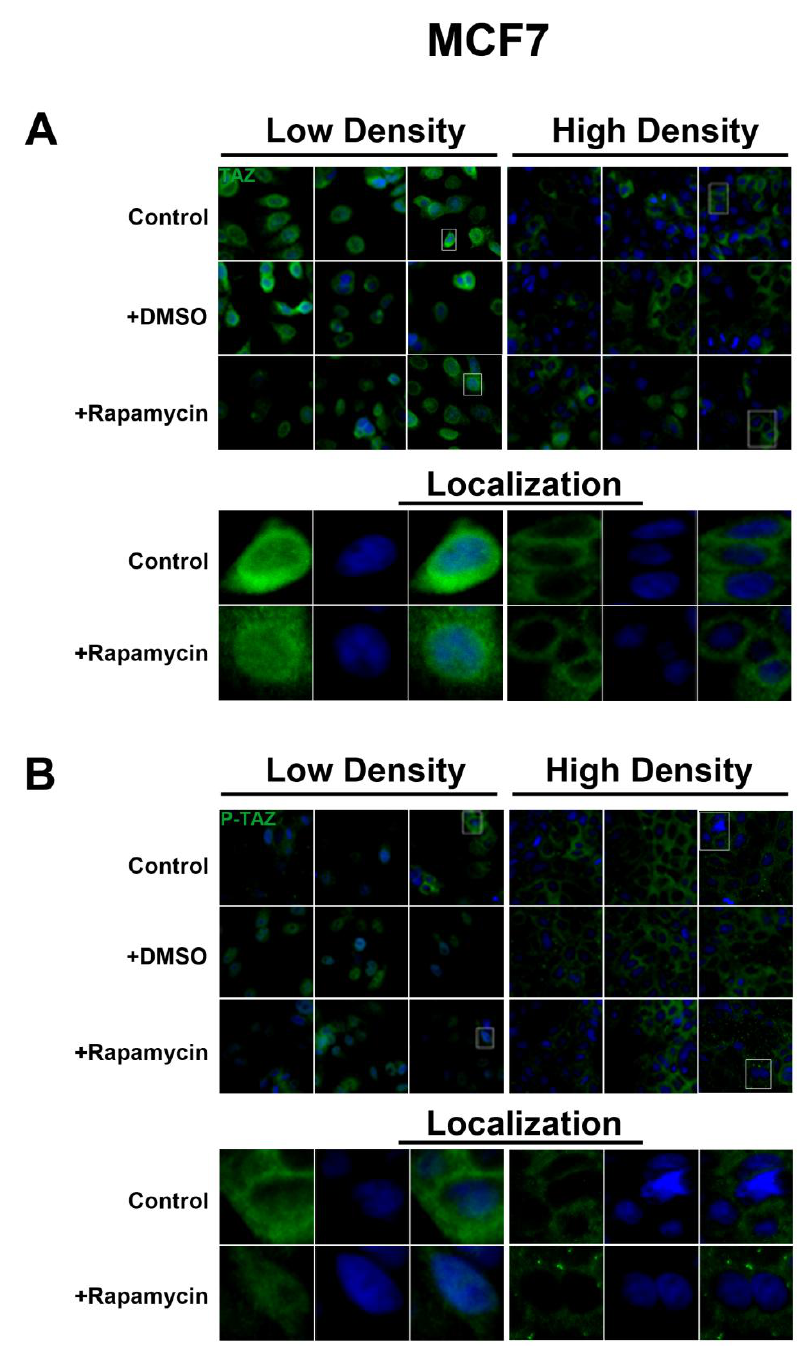
Figure S3. mTOR pathway inhibition does not affect TAZ/P-TAZ expression or localization in MCF7 cells. (A-B) Immunofluorescent staining of TAZ (A, green) and P-TAZ (B, green) in MCF7 cells with and without rapamycin treatment at low and high cell density conditions demonstrates no changes. Bottom panels represent box in top images: localization of TAZ and P-TAZ at low cell density conditions demonstrates mostly nuclear localization that does not change upon rapamycin treatment, while in high density conditions, TAZ and P-TAZ is cytoplasmic and does not change upon rapamycin treatment. TOPRO3 (blue) labels nuclei. Scale bars, 20